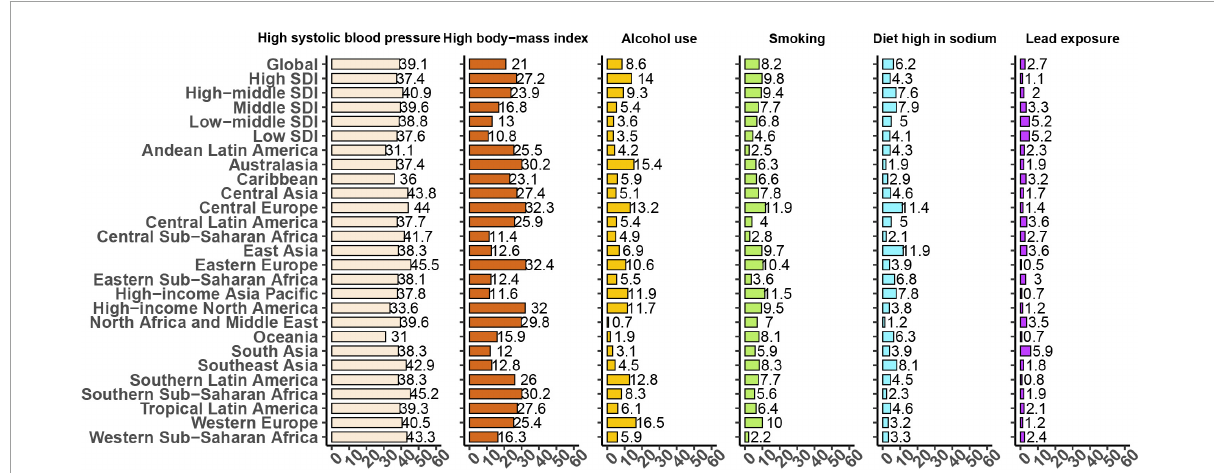
FIGURE6 Proportion of age-standardized disability-adjusted life-years (DALYs) due to atrial fibrillation attributable to risk factors for 21 Global Burden of Disease regions, both sexes, 2019.